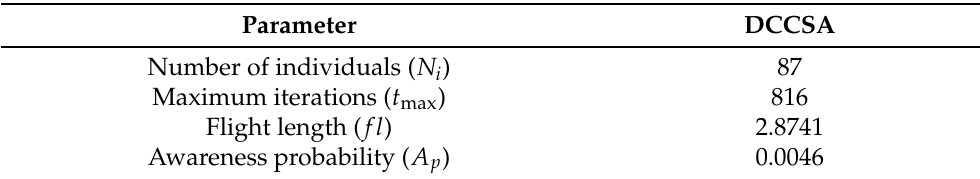
Table 2. Parameters of the DCCSA employed in the master